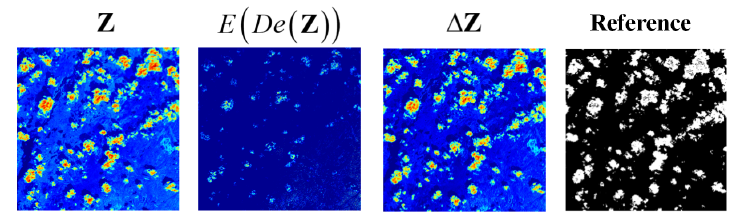
Figure 2. An example of a residual error